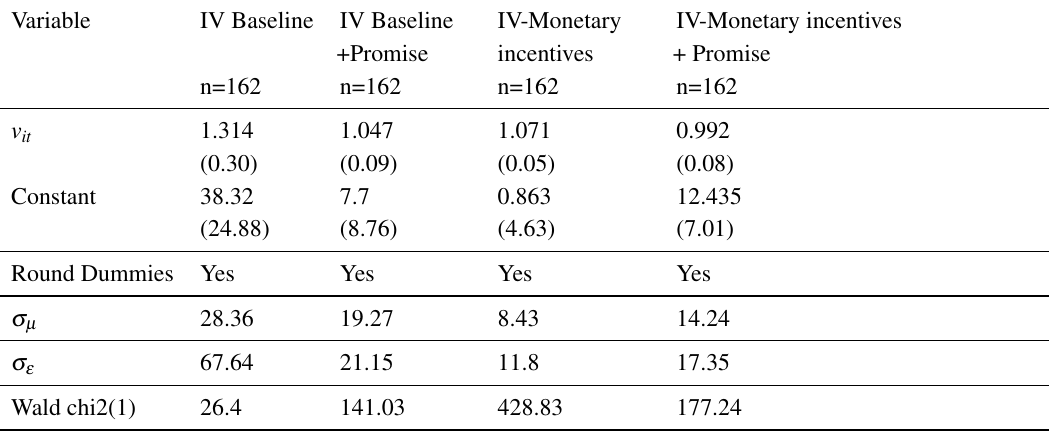
Table 7: IV bidding behavior - Individual random effect model